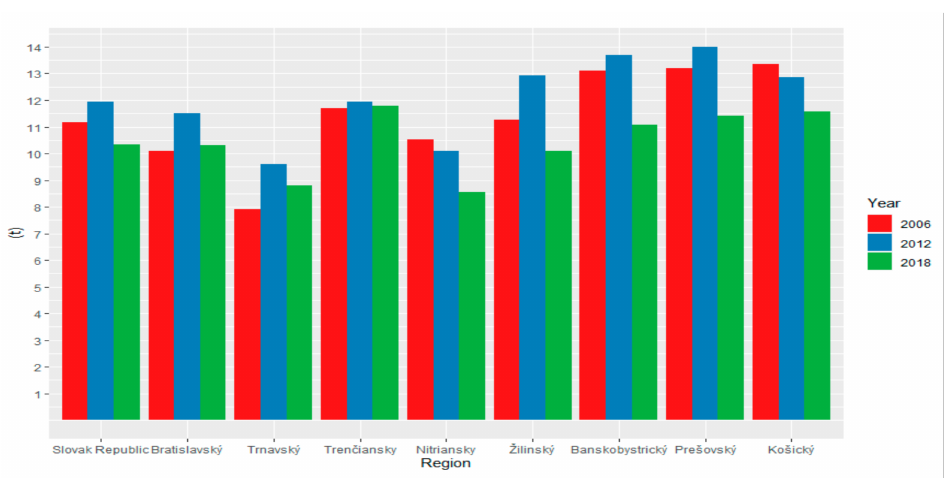
Figure 7. Development of waste